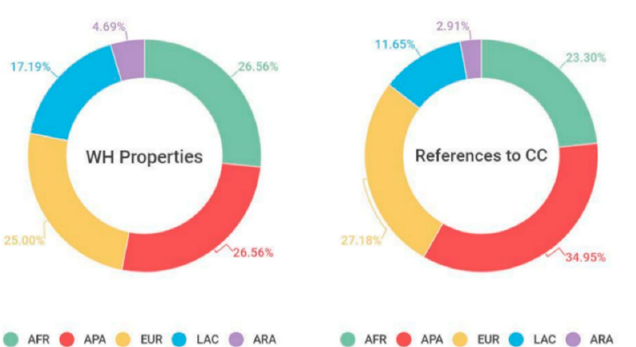
Figure 3. Distribution of WH properties discussing climate change (in %) and total references to climate change (cc) per The United Nations Educational, Scientific and Cultural Organisation (UNESCO) geographical area.